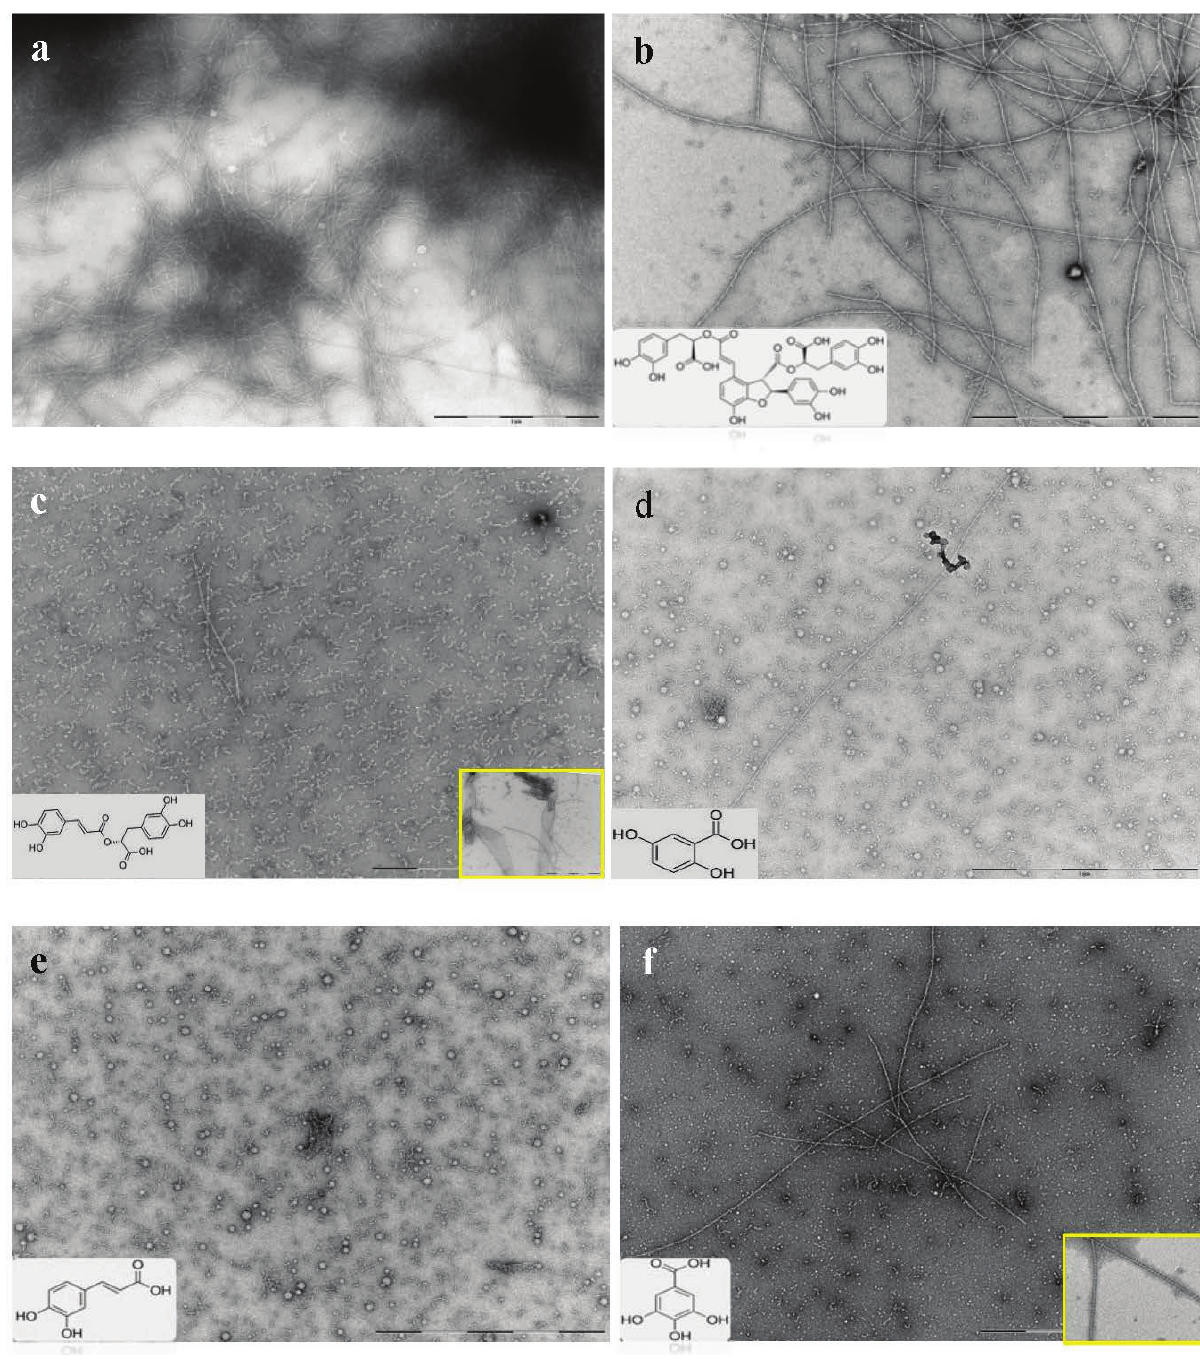
Figure 5. TEM micrograph of A(cid:2) 42 co-incubated with selected compounds. ( a ) Morphological effects of selected compounds on chemically synthesized A(cid:2) 42 aggregation was investigated and compared with the control sample. ( b ) Micrograph of chemically synthesized A(cid:2) 42 in presence of salvianolic acid B; ( c ) rosmarinic acid; ( d ) 2,5-DHBA (gentisic acid); ( e ) 3,4-DHCA (caffeic acid); and ( f ) 3,4,5-THBA (gallic acid). Arrows show micelle (globular) structures, protofibrils, and fibrillar species of A(cid:2) 42 . A micrograph showing other conformational species of peptide formed by the compound is highlighted in the yellow box. The structure of each compound is also shown on the micrograph. (Scale bars = 200